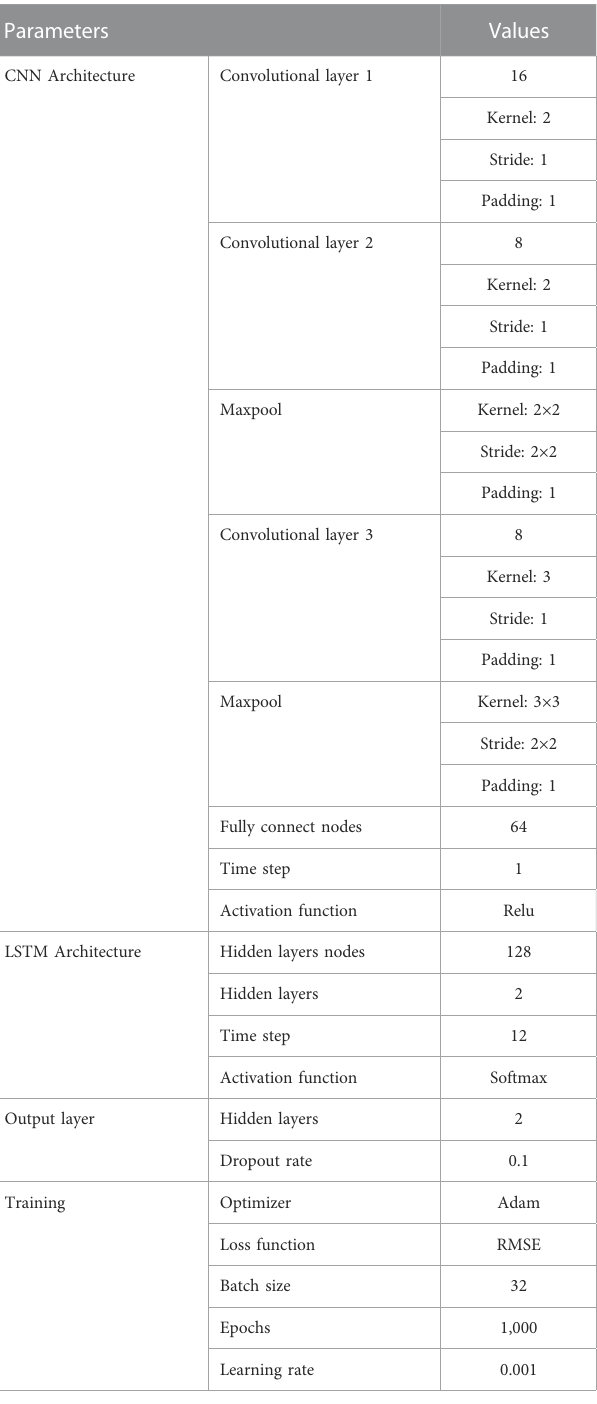
TABLE 4 Setting of hyperparameters. Parameters Values CNN